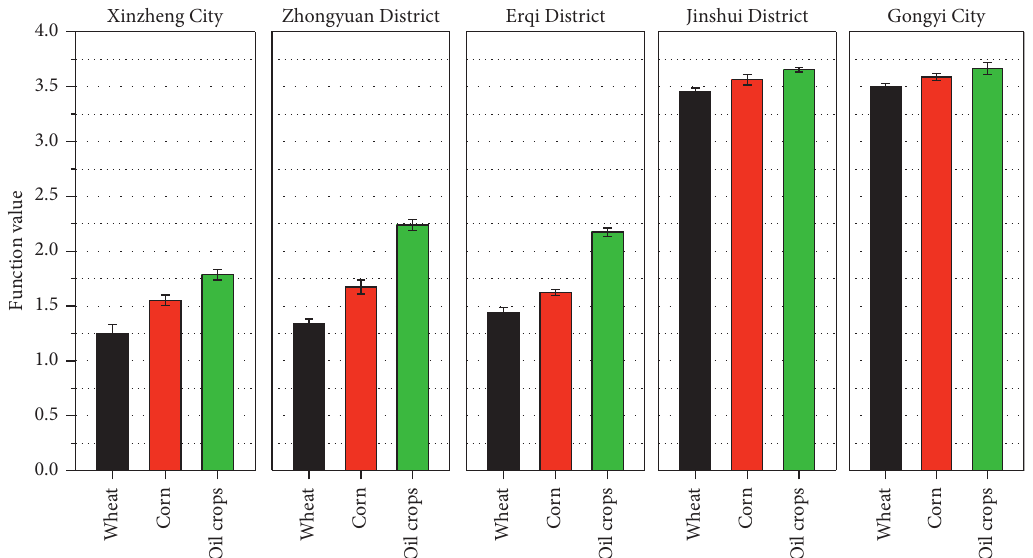
Figure 8: Function values between different crops in different urban